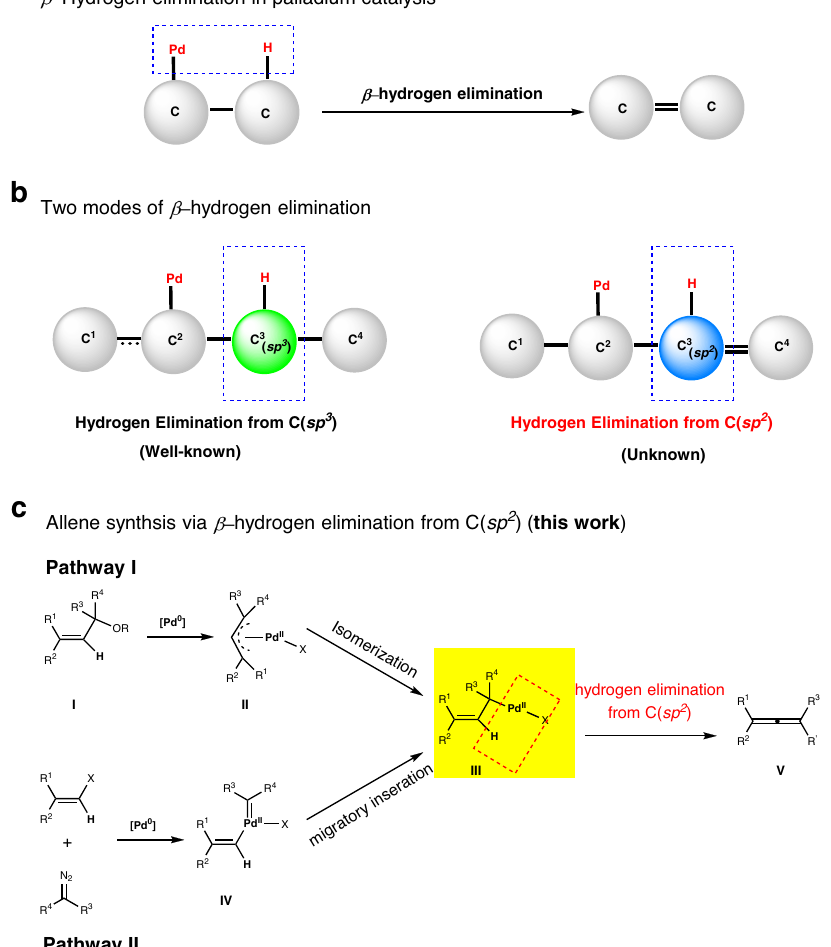
Fig. 1 Allene synthesis based on β -hydrogen elimination from sp 2 hybrid carbon. a β -Hydrogen elimination in palladium catalysis. b Two modes of β -hydrogen elimination. c Allene synthesis via β -hydrogen elimination from C( sp 2 ) (this